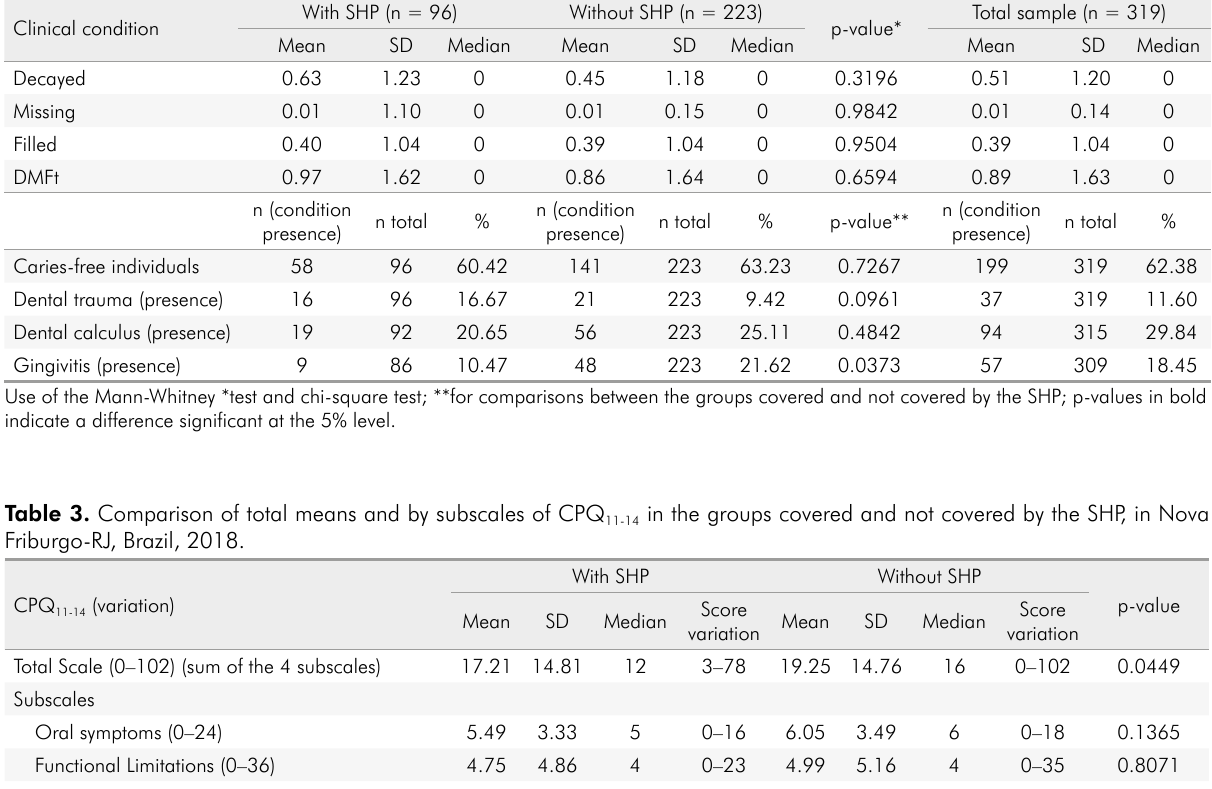
Table 2. Clinical characterization of the oral health conditions of the total samples and the subsamples covered and not covered by the SHP in the municipality of Nova Friburgo. Nova Friburgo, RJ, Brazil, 2018. Clinical condition Decayed Missing 0.01 Filled